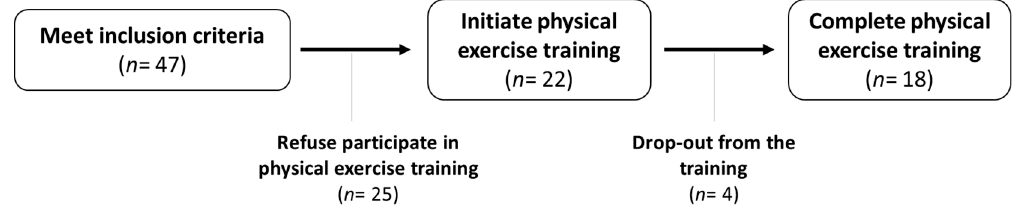
Figure 1. Flowchart of participants.